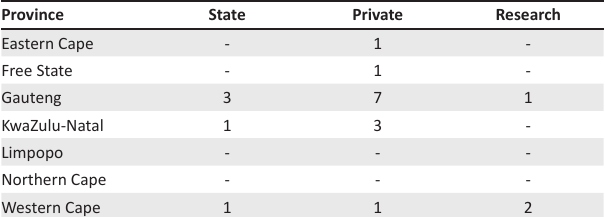
TABLE 1: Provincial distribution of PET-CT scanners in South Africa.